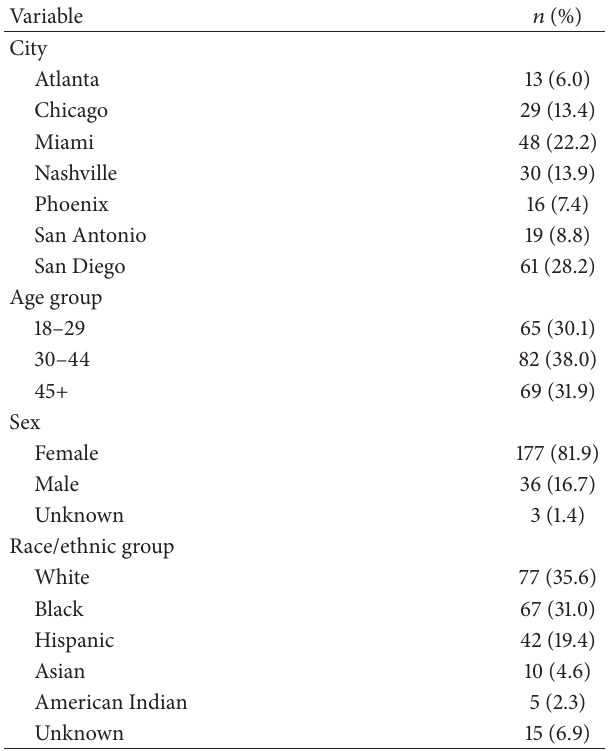
Table 1: Demographic characteristics of participants: the ford see me safe child passenger safety education